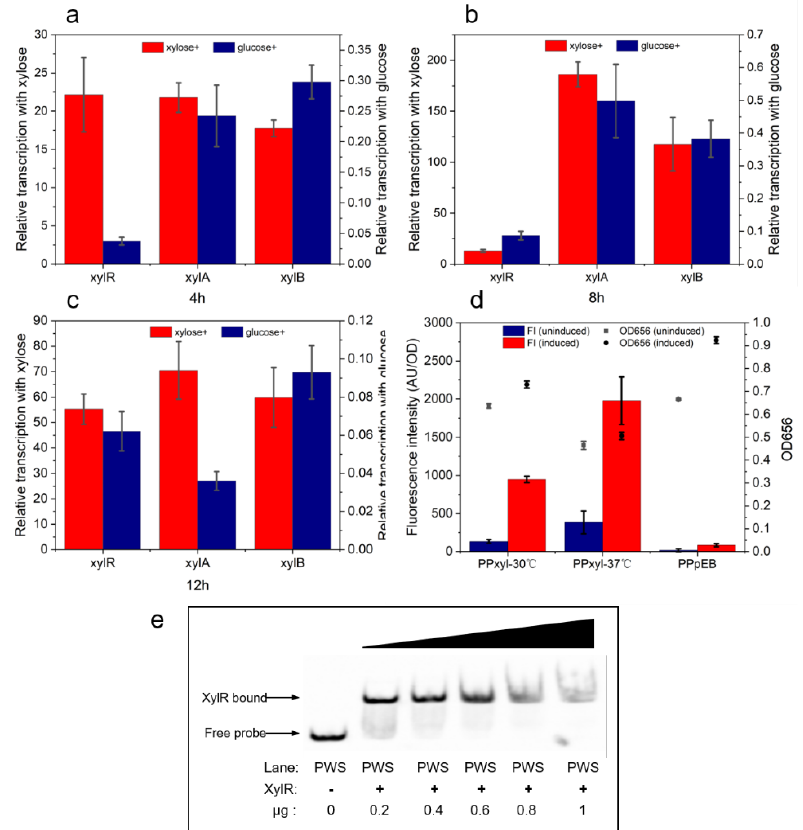
Figure 1. Experimental evidence for regulation of the predicted operon by xylose. Transcriptional strengths of xylR , xylA , and xylB after 4 h ( a ), 8 h ( b ), and 12 h ( c ) of culture with xylose or glucose. The fluorescence intensity level of eGFP ( d ) expressed by the predicted xylose-inducible promoter in the presence of 2% xylose. ATCC842 containing pHY300PLK-eGFP was the control and is labeled as PPpEB. The EMSA assay result ( e ) shows the binding capacity of XylR to the predicted promoter.